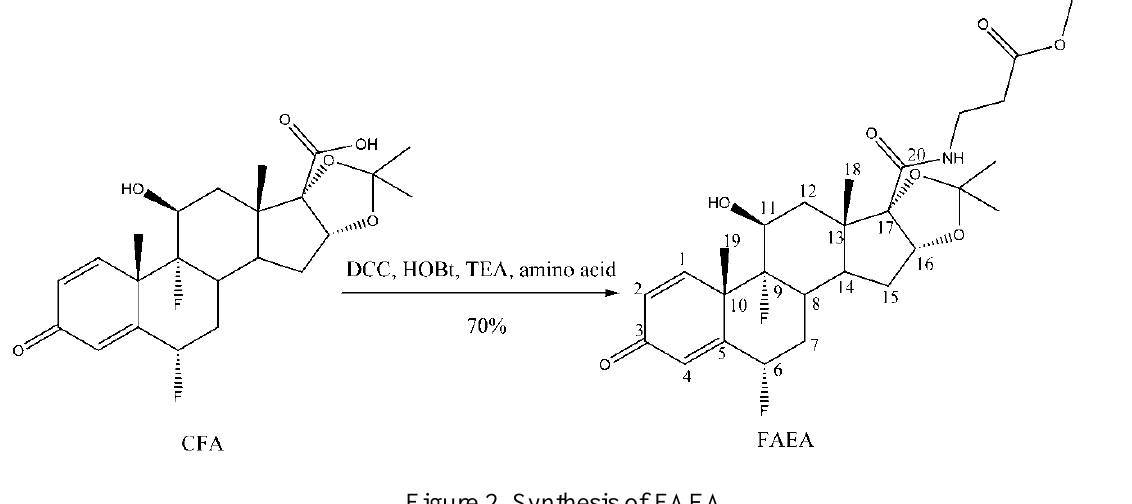
Figure 2. Synthesis of FAEA